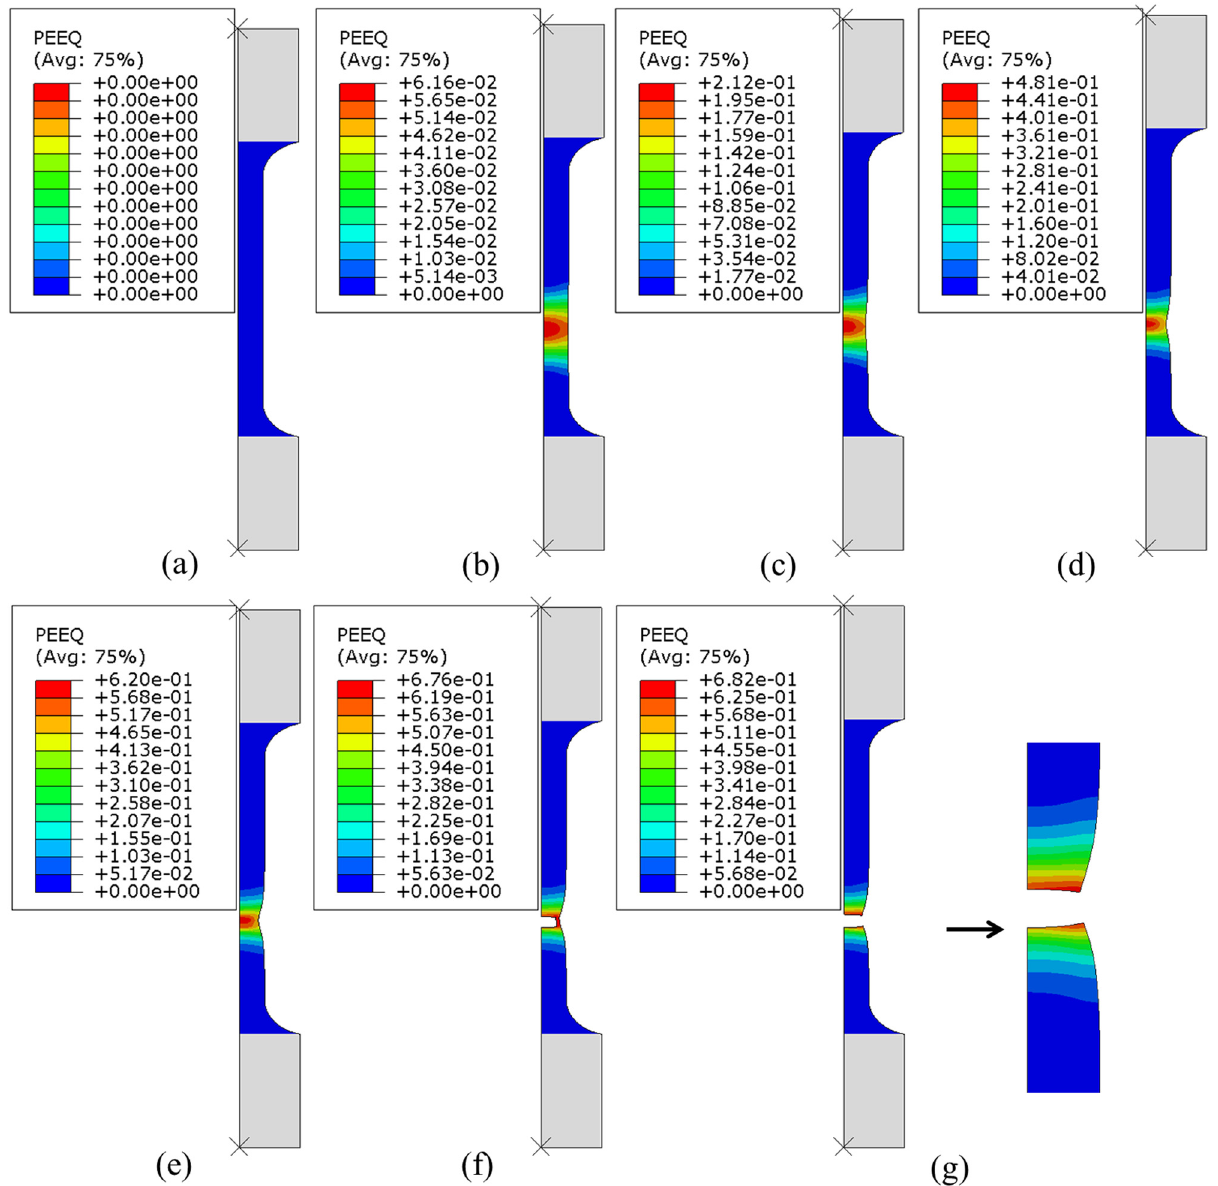
Figure 11: The distribution of equivalent plastic strain at the true strain of ( a ) 0 s − 1 , ( b ) 0.05 s − 1 , ( c ) 0.1 s − 1 , ( d ) 0.15 s − 1 , ( e ) 0.2 s − 1 , ( f ) 0.229 s − 1 , and ( g ) 0.23 s − 1